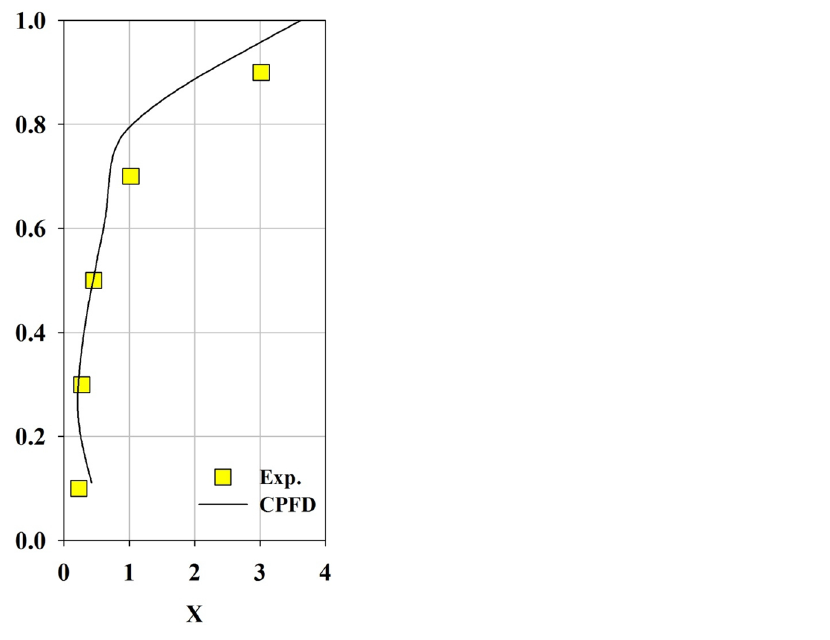
Figure 4. Comparison between the CPFD analysis and experimental data.